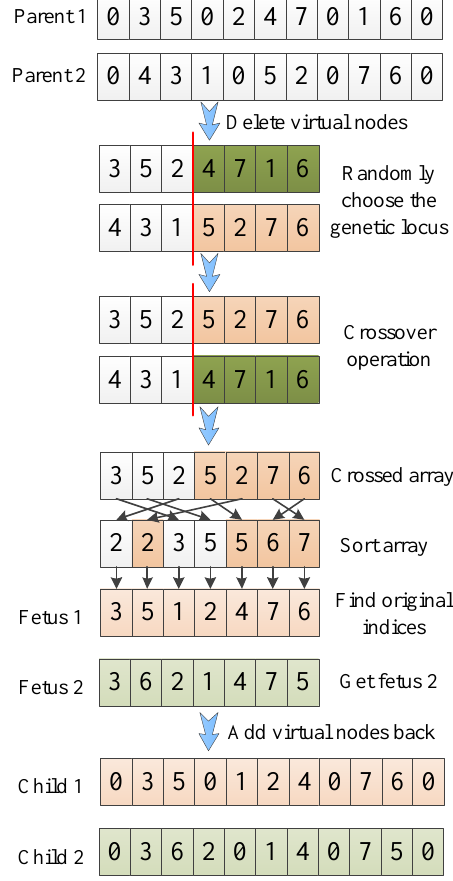
Figure 4. Process of crossover operation of the Modified Genetic Algorithm